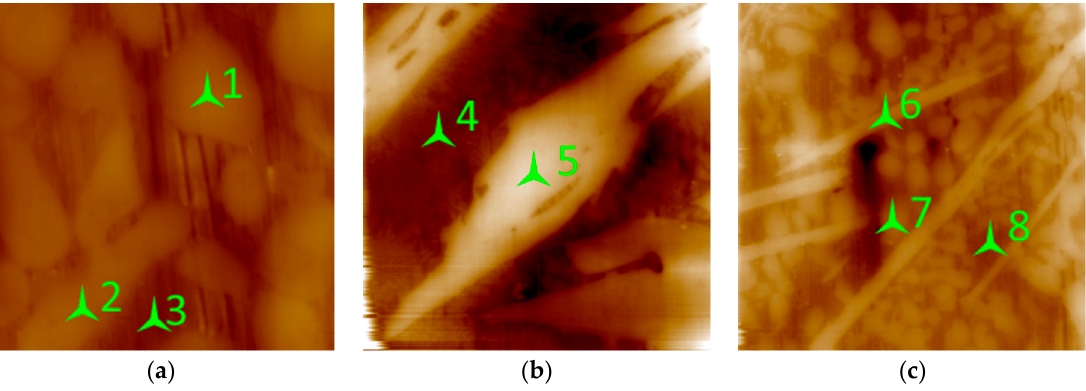
Figure 6. The AFM pattern and the location of measurement points: ( a ) small carbides in the center of weld 2, 15 × 15 μ m, ( b ) the tip of long boride in the transition zone between welds 2 and 3, 40 × 40 μ m, and ( c ) long borides and small carbides in the transition zone between welds 1 and 2, 40 × 40 μ m. Table 3. The nanohardness values of the coating constituents. Indent